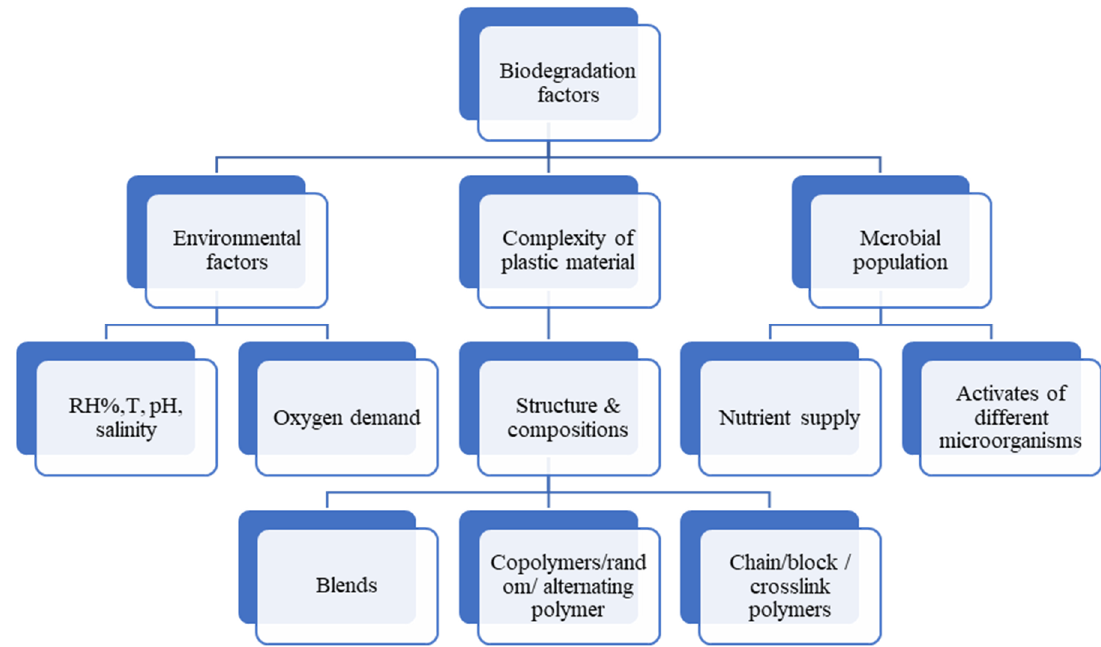
Figure 2. Environmental factors that influence biodegradation.